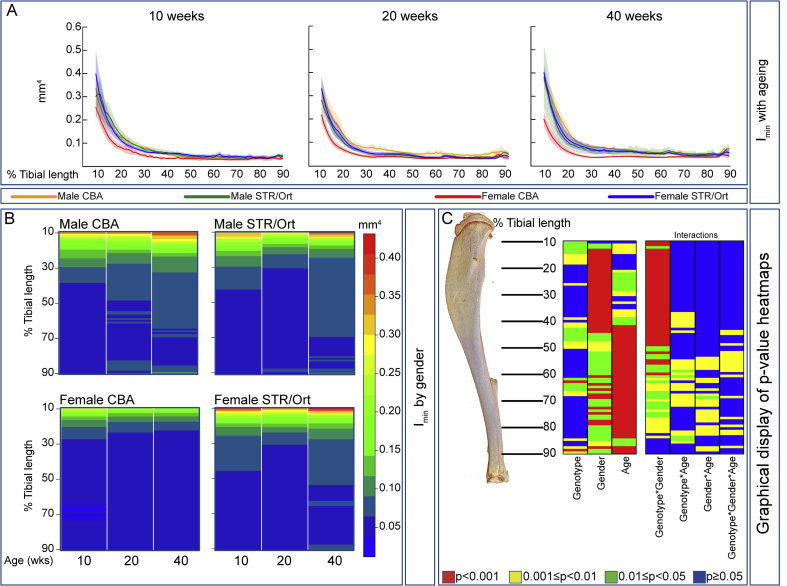
Analysis of Iminalong the entire length of the tibia. (A) Mean Imin in male and female CBA (brown and red, respectively) and STR/Ort (green and blue, respectively) mice at 10, 20 and 40 weeks of age. (B) ‘Heat map’ representation of identical data-set (red-blue colour scale depicts mean Imin) for male and female CBA (left) and male and female STR/Ort (right) enabling ready comparison (at each percentile of length) between 10, 20 and 40 weeks of age. (C) Statistical significance of differences in Imin along the entire tibial shaft, represented as a heat map. The contributions of genotype (CBA vs STR/Ort), gender, age (10, 20 and 40 weeks), and their interactions at locations from 10 to 90% of tibial length are illustrated. Red P < 0.001, yellow 0.001 ≤ P < 0.01, green 0.01 ≤ P < 0.05 and blue P ≥ 0.05. Line graphs represent means with 95% CI. Group sizes were n = 5 for male and female CBA and STR/Ort mice.